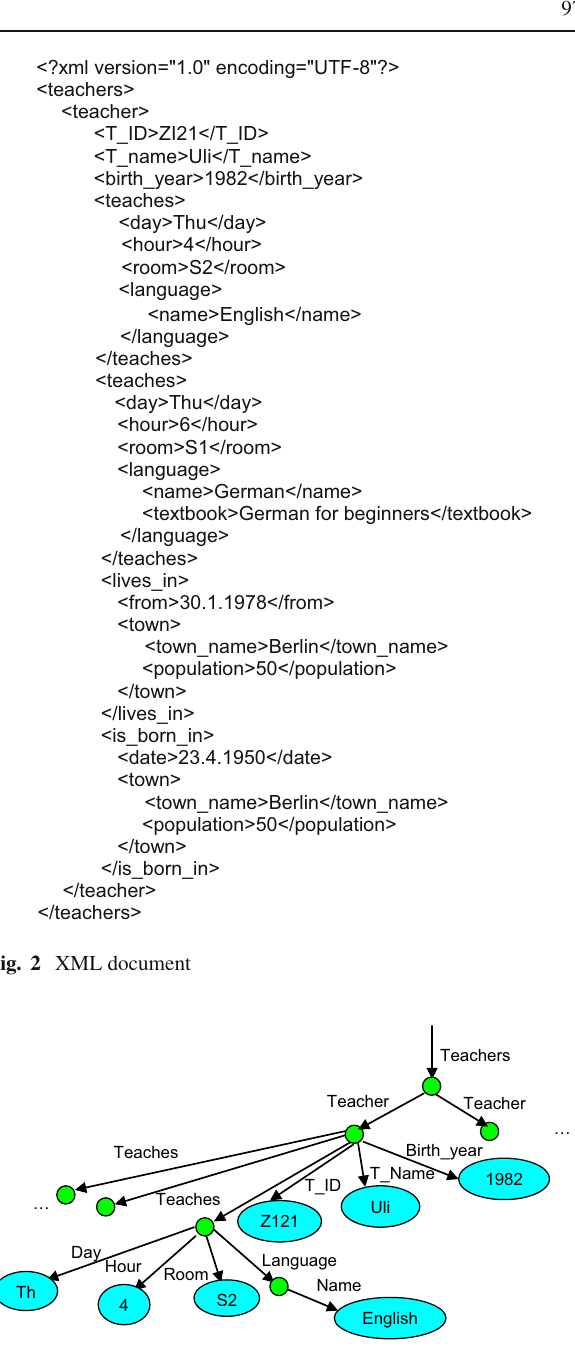
Fig. 3 Tree representation of XML document in Fig. 2 (a part)